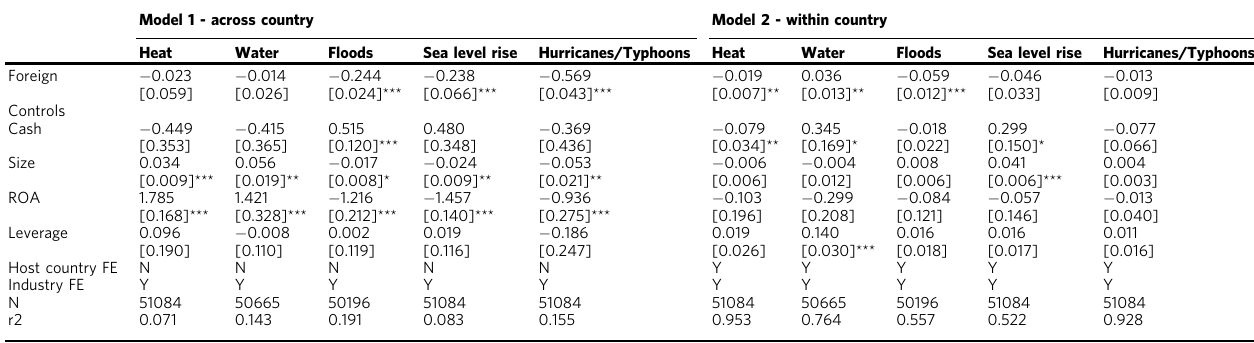
Table 1 Difference of climate risks of foreign-owned/operated